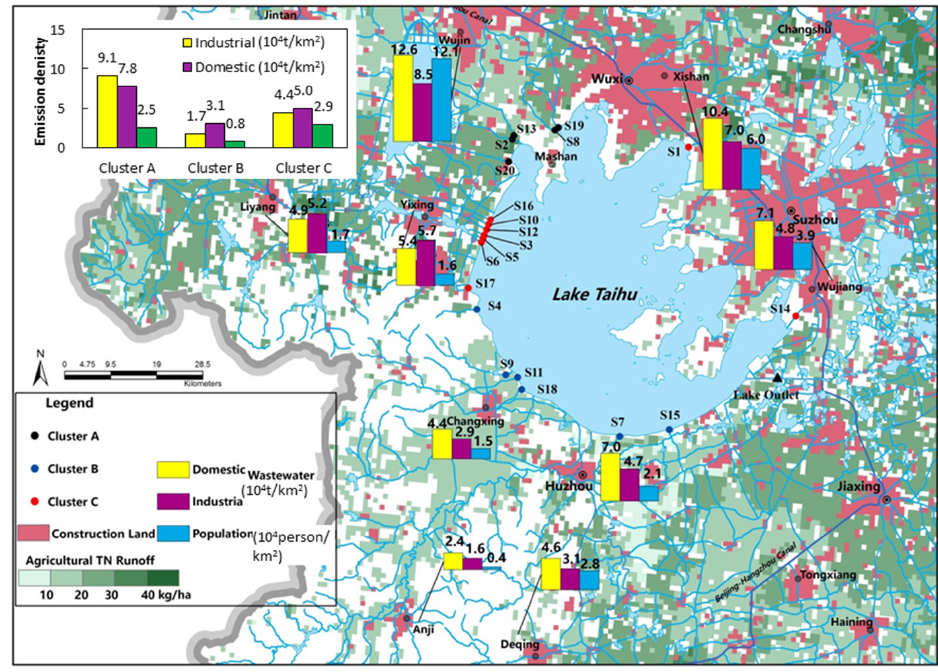
Figure 3. Spatial pattern of the grouping of monitoring sites and the corresponding emission rates